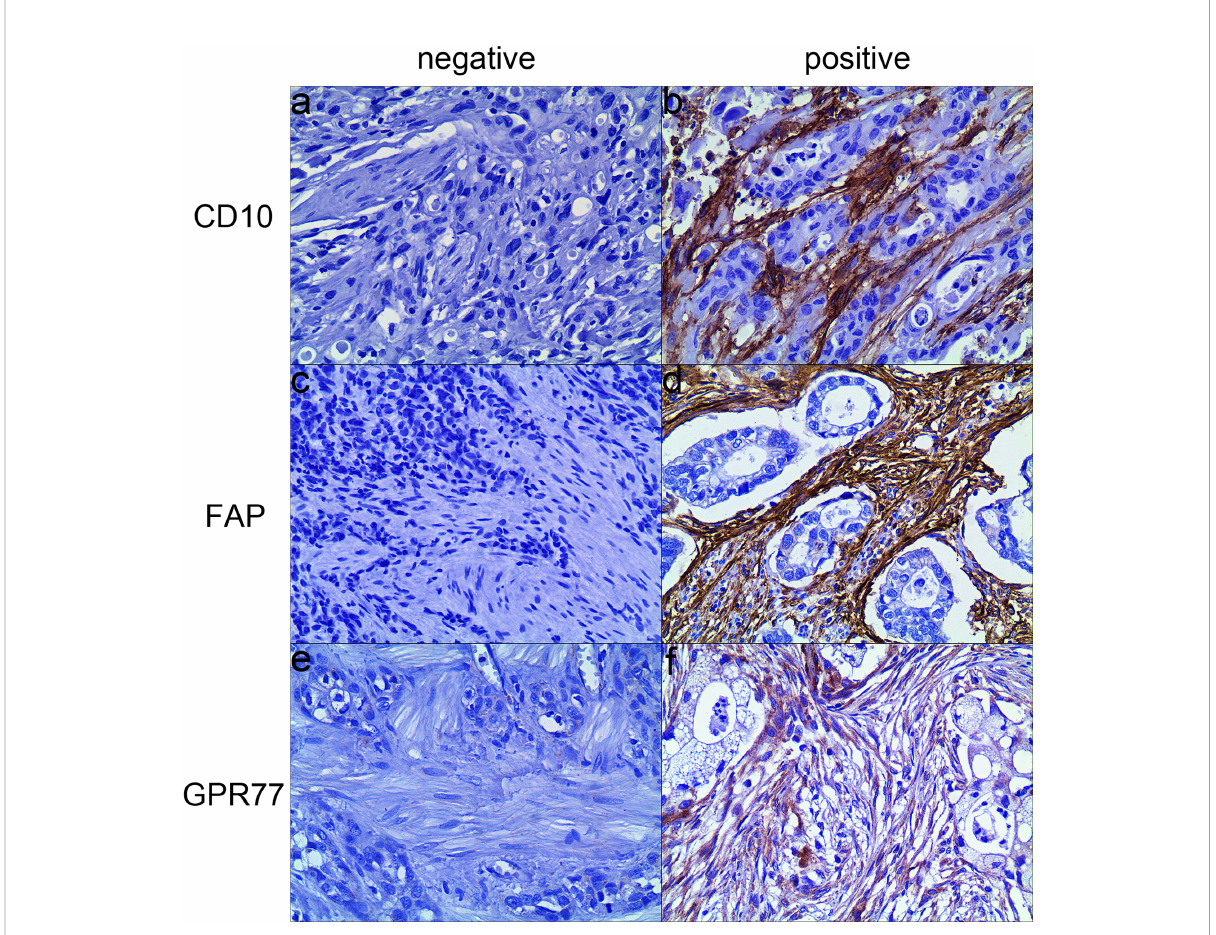
FIGURE 2 Representative examples of three biomarkers expression by immunohistochemistry (200×). (A) CD10 was negatively expressed in CAFs; (B) CD10 was positively expressed in the cytoplasm and membrane of CAFs; (C) FAP was negatively expressed in CAFs; (D) FAP was positively expressed in the cytoplasm of CAFs; (E) GRP77 was negatively expressed in CAFs; (F) GPR77 was positively expressed in the cytoplasm and membrane of CAFs.